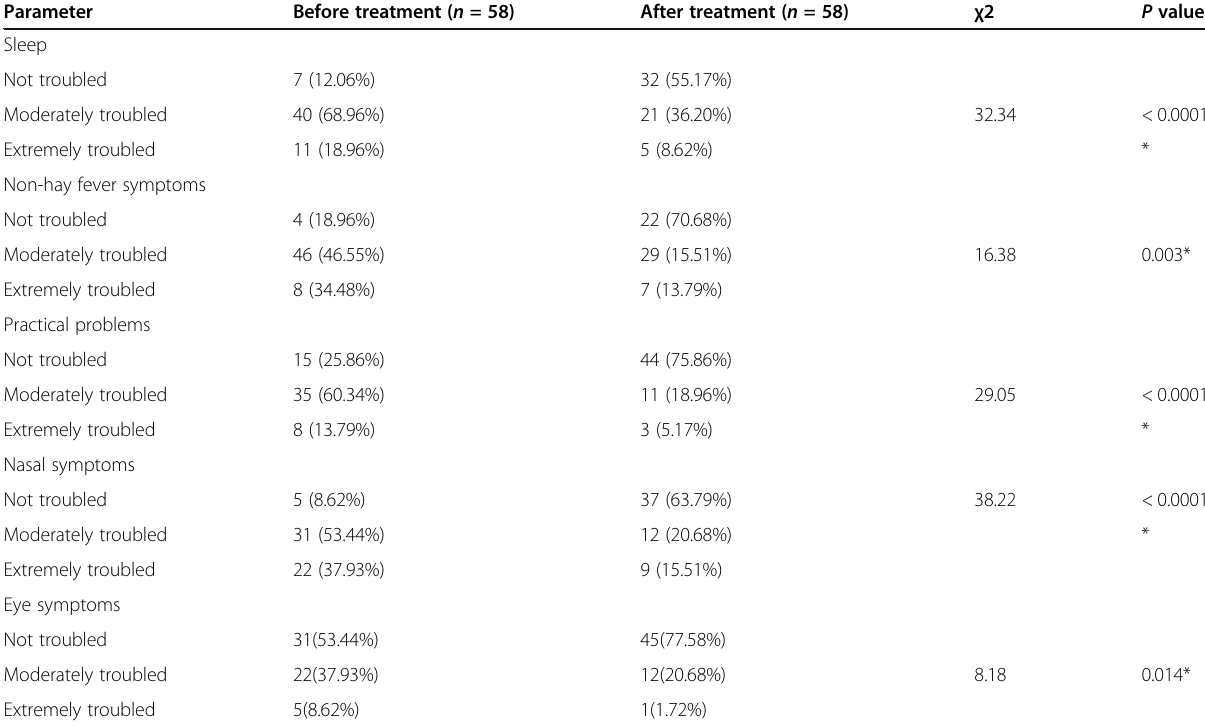
Table 4 Quality of life assessment